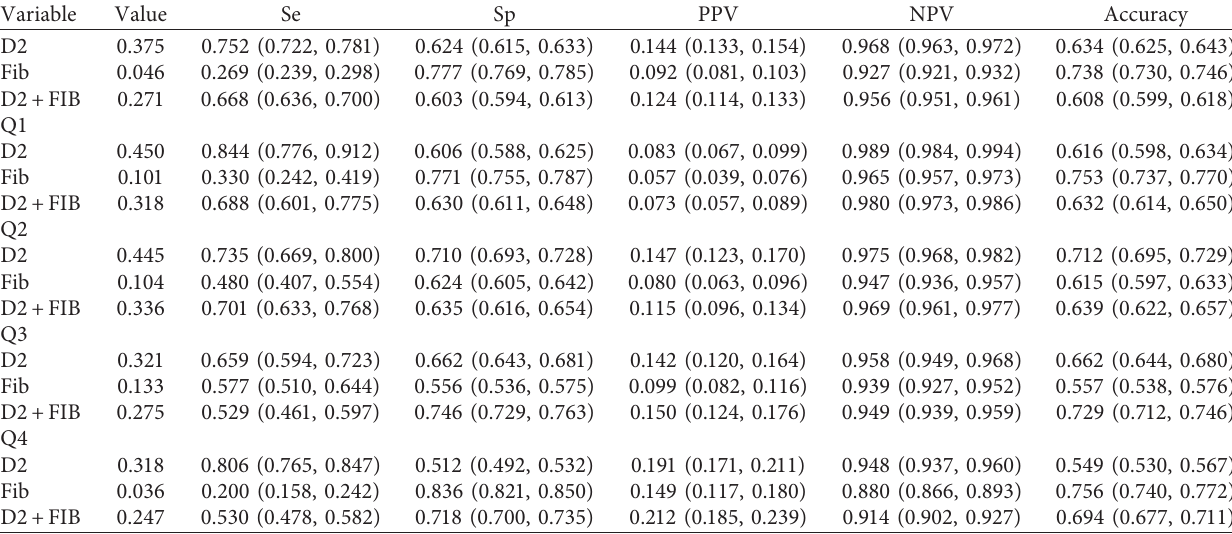
Table 4: Sensitivity, specificity, positive predictive value, and negative predictive value of D-dimer, fibrinogen, and combination of D-dimer and fibrinogen based on the Youden